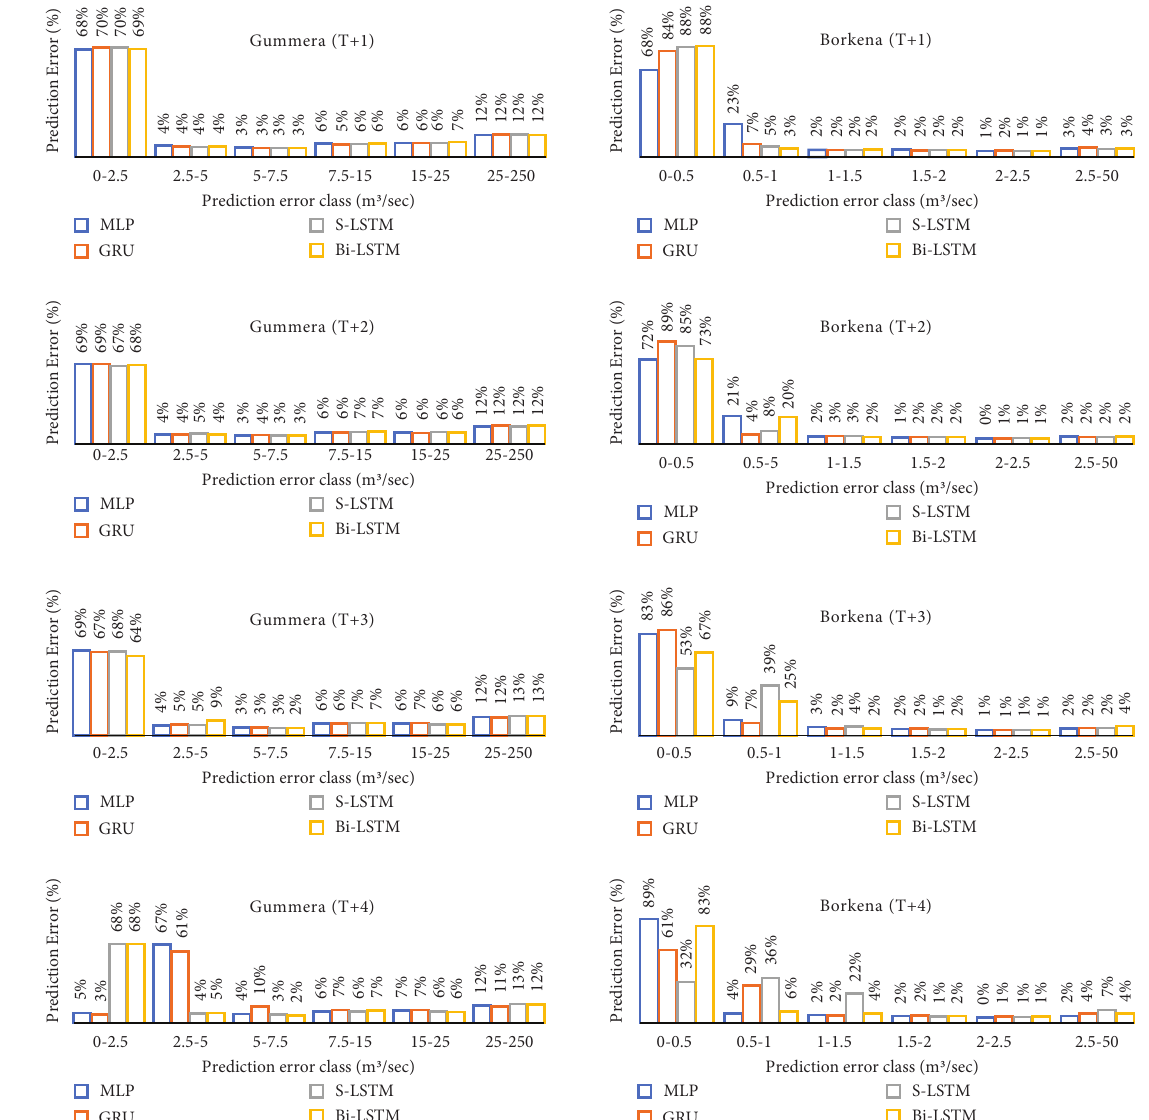
Figure 9: Bar chart showing the frequency (%) of absolute prediction errors |PE| (m 3 /sec) with different class limits for the proposed four models and input lagged time variables in both